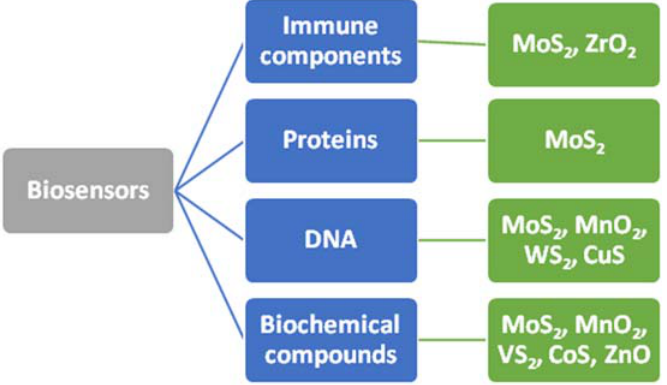
Figure 6. Demonstration of the ability of some 2D non-graphene material-based biosensors to be used for the detection or control of different biological substances.